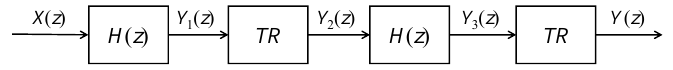
Figure 14. Implementation of a real-time, causal linear phase IIR filter using time reversal